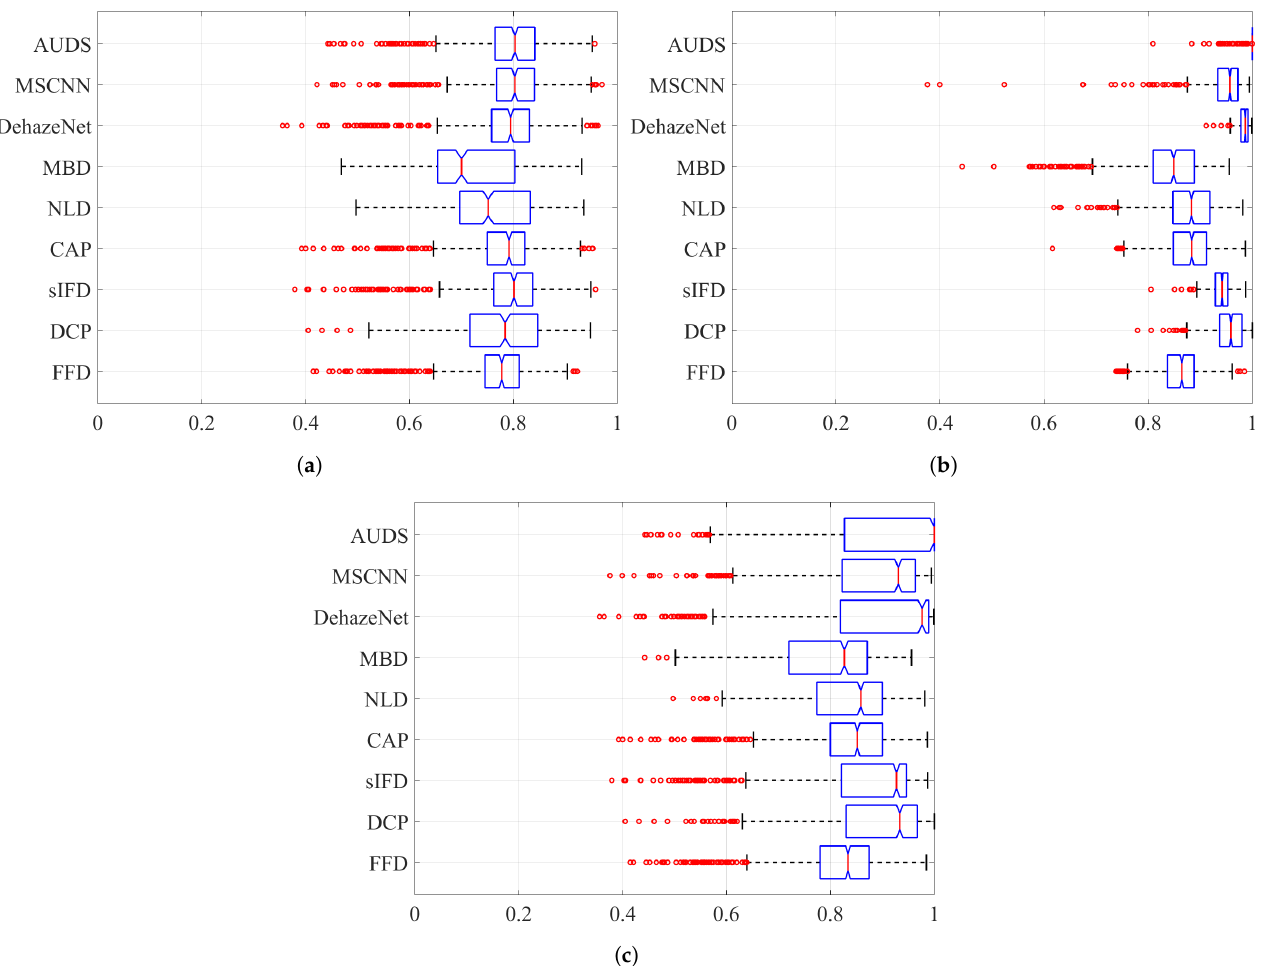
Figure 8. Boxplots of FSIMc scores on different datasets when considering: ( a ) hazy images only, ( b ) haze-free images only, and ( c ) both hazy and haze-free